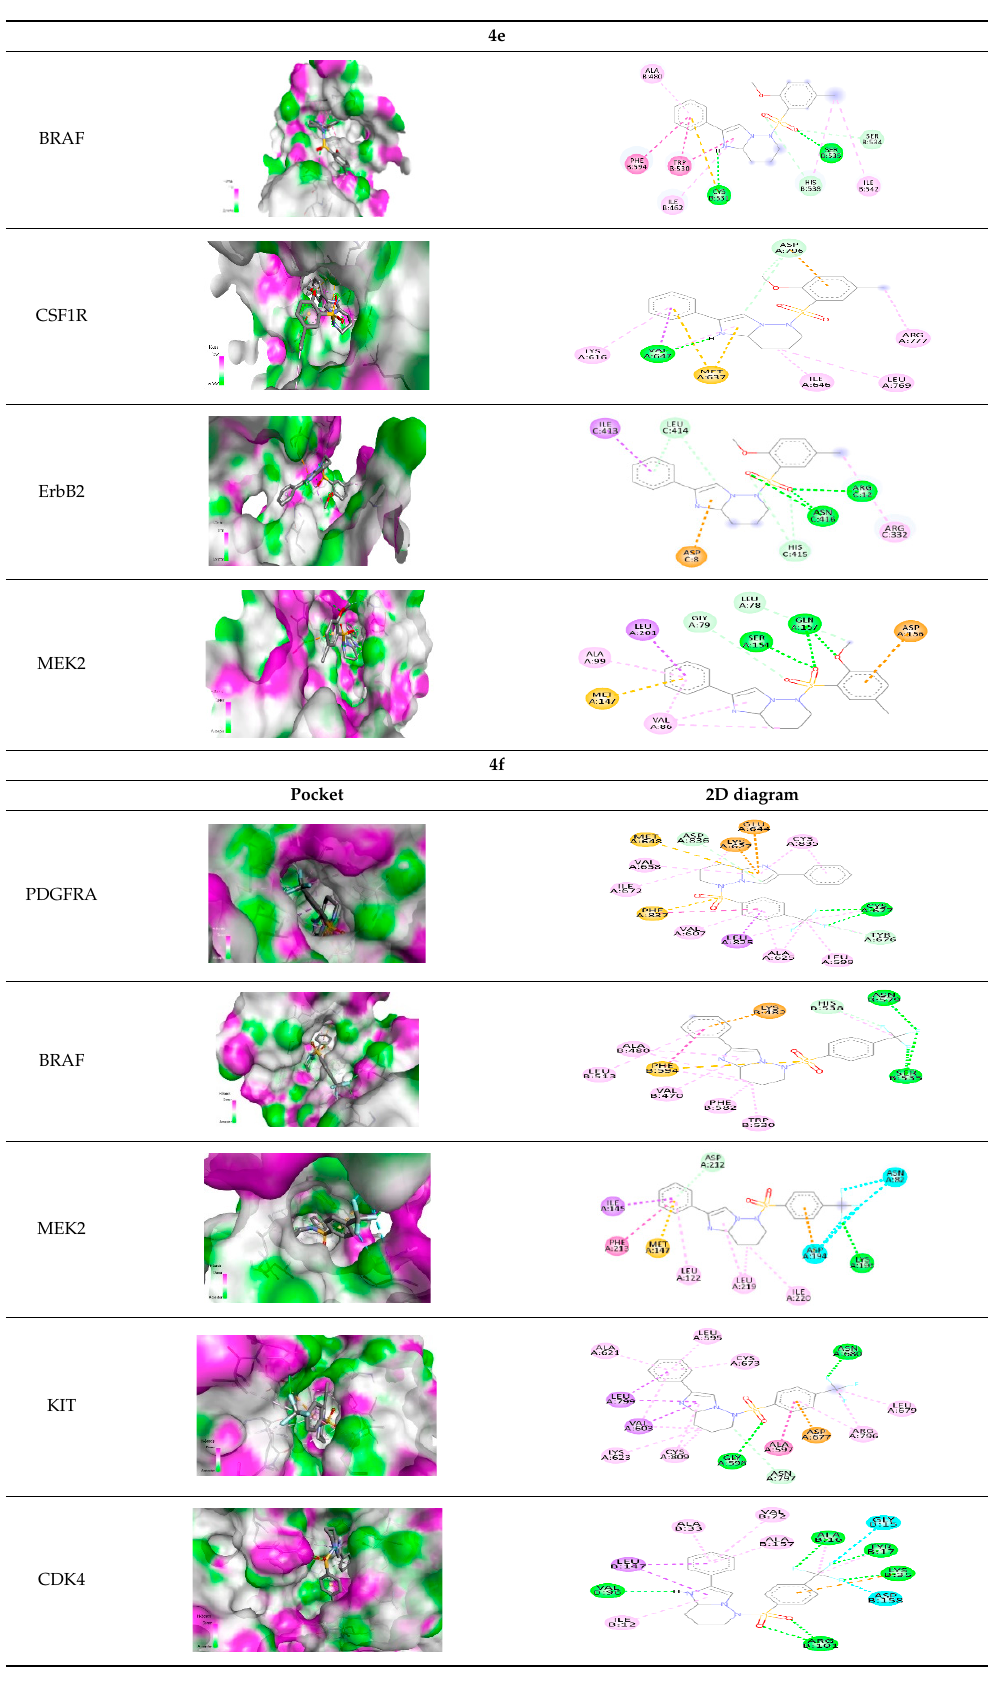
tively, with 13 non-bond links each (Table 3). Table 3. Illustrations in 3D and 2D of the best interactions for 4e (A) and 4f (B) and aminos acids Table 3. Illustrations in 3D and 2D of the best interactions for 4e (A) and 4f (B) and aminos acids Table 3. Illustrations in 3D and 2D of the best interactions for 4e (A) and 4f (B) and aminos acids Table 3. Illustrations in 3D and 2D of the best interactions for 4e (A) and 4f (B) and aminos acids within the active site of different kinases. within the active site of different within the active site of different kinases. within the active site of different kinases. Table 3. Illustrations in 3D and 2D of the best interactions for 4e (A) and 4f (B) and aminos acids Table 3. Illustrations in 3D and 2D of the best interactions for 4e (A) and 4f (B) and aminos acids Table 3. Illustrations in 3D and 2D of the best interactions for 4e (A) and 4f (B) and aminos acids Table 3. Illustrations in 3D and 2D of the best interactions for 4e (A) and 4f (B) and aminos acids within the active site of different kinases. within the active site of different kinases. Table 3. Illustrations in 3D and 2D of the best interactions for 4e (A) and 4f (B) and aminos acids Table 3. Illustrations in 3D and 2D of the best interactions for 4e (A) and 4f (B) and aminos acids Table 3. Illustrations in 3D and 2D of the best interactions for 4e (A) and 4f (B) and aminos acids Table 3. Illustrations in 3D and 2D of the best interactions for 4e (A) and 4f (B) and aminos acids within the active site of different kinases. within the active site of different kinases. within the active site of different kinases. within the active site of different kinases. within the active site of different kinases. within the active site of different kinases. Table 3. Illustrations in 3D and 2D of the best interactions for 4e (A) and 4f (B) and aminos acids within the active site of different kinases.